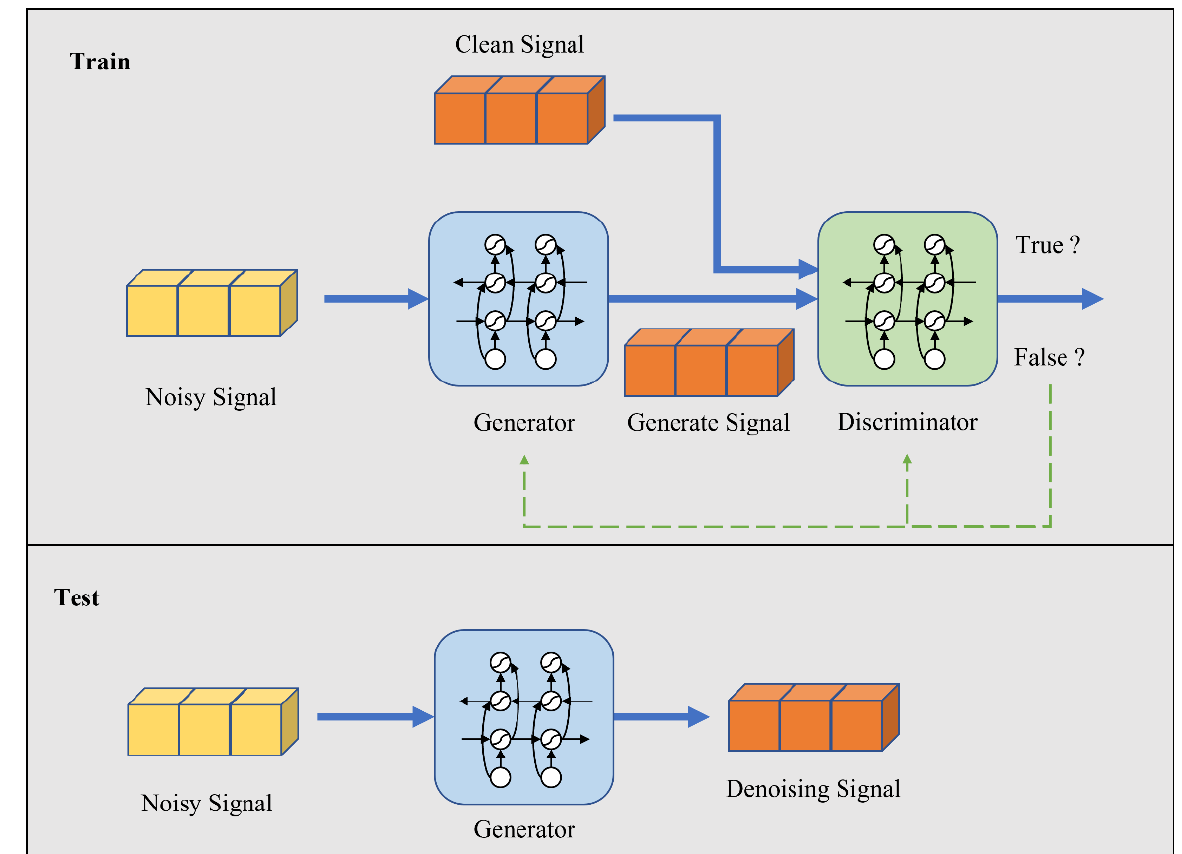
Figure 1. Signal noise reduction model based on RaGAN and training and testing process.